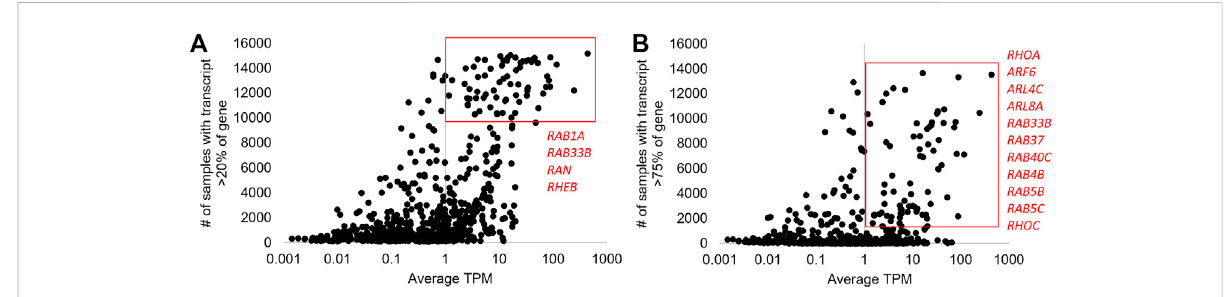
FIGURE 4 “ Blood PAXgene ” based changes in small GTPase isoforms. (A) The Analysis of 16,243 samples from 116 NCBI BioProjects for isoforms of small GTPase genes. The x -axis shows the average transcripts per million (TPM) for each isoform, and the y -axis shows the number of samples where that isoform is greater than 20% of the total gene expression. The red box is around those isoforms with > 10,000 samples and one TPM; the four genes with more than one isoform are labeled in red. (B) The same plot in (A) shows the y -axis for samples greater than 75%. The red box is around those with > 2,000 samples and 1 TPM, with the 11 genes having > 1 isoform in the box labeled in